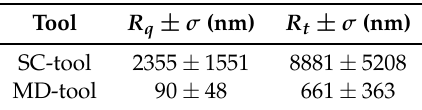
Table 5. Average values of the cutting edge roughness R q and R t for the SC- and MD-tool with the standard deviation σ .